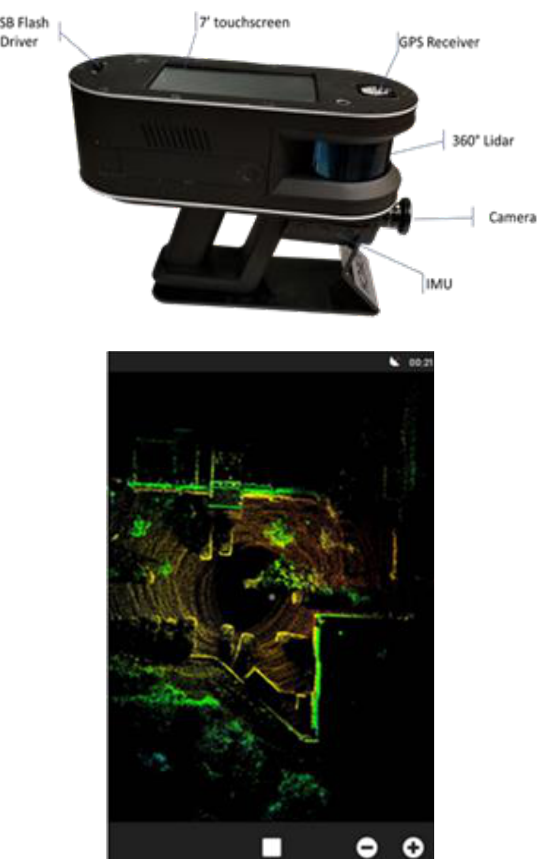
Figure 1 . The view from study area